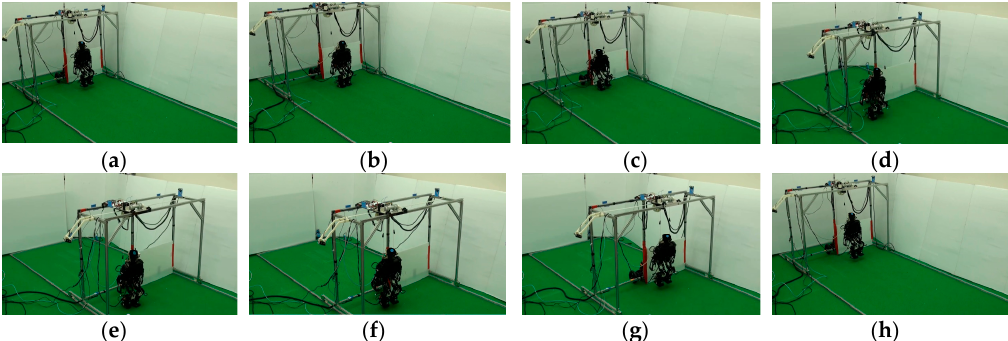
Figure 20. Snapshot of the one learning process: ( a ) robot is suspended by the automatic training platform in the start state; ( b ) robot is lowered by the automatic training platform in the start state; ( c ) automatic training platform moves forward to follow the robot in the operation state; ( d ) automatic training platform moves forward and right to follow the robot in the operation state; ( e ) robot is in the danger region and is followed by the automatic training platform in the end state; ( f ) robot is pulled up by the automatic training platform in the end state; ( g ) automatic training platform goes back in the return state; ( h ) automatic training platform is at the initial position in the return state.